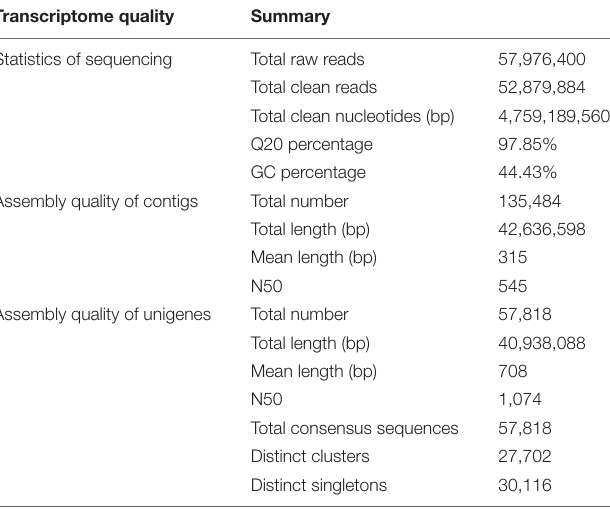
TABLE 4 | Summary of the S. cruentus ray floret transcriptome.